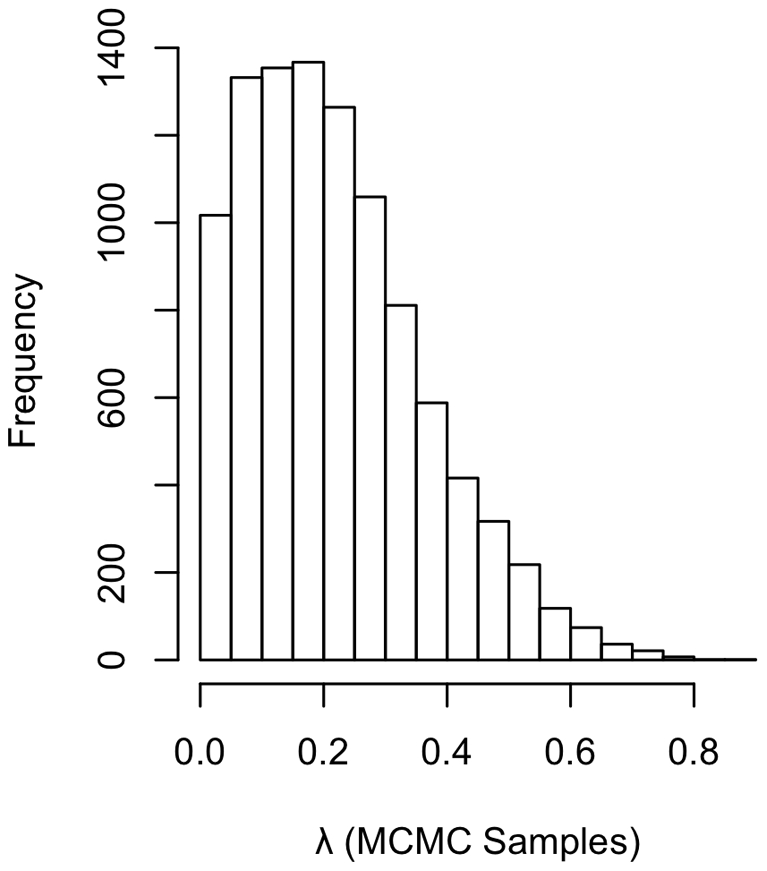
Distribution of λ in regression of male number on female number.The distribution of λ is wide, but shows a peak at about 0.2. Thus, internal branches are scaled to 1/5 of their original lengths. This result suggests low, but meaningful, phylogenetic signal in the data.